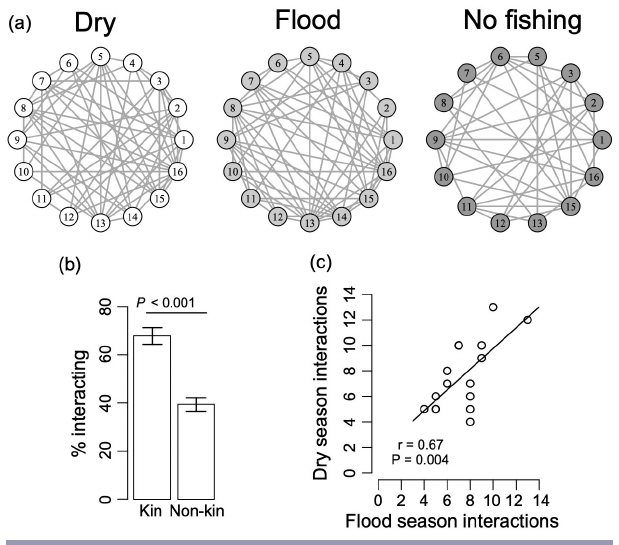
Fig. 4 . Social interactions between households in Barra do Sao Lorenço community. (a) Social network graphs of interactions between households across seasons. Circles are households, and edges represent interactions during the two weeks studied. Household order is the same in both graphs; (b) proportion of interactions between households that are kin (related by s ≥ 0.25) or non-kin (s < 0.25); (c) correlation between the number of interaction between households in each